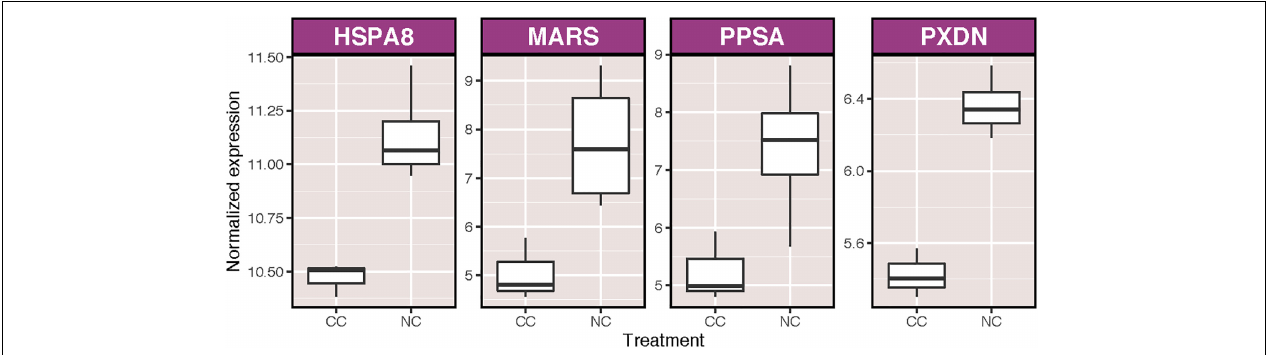
FIGURE 2 | Variance stabilized normalized expression of annotated transcripts that were significantly differentially expressed as a result of the addition of nutrients to coral samples. Genes are listed in alphabetical order. Those displayed are: heat shock protein 70 kDA 8 (HSPA8), methionine-tRNA ligase (MARS), phthiocerol